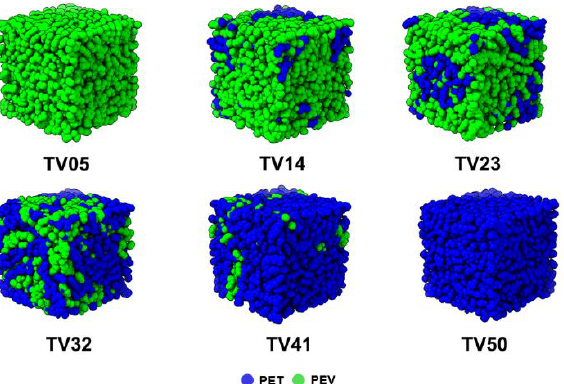
Figure 3. Simulated morphologies of PET, PEV, and PET/PEV blends at different composition ratios. The blue and green colors represent PET and PEV, respectively.